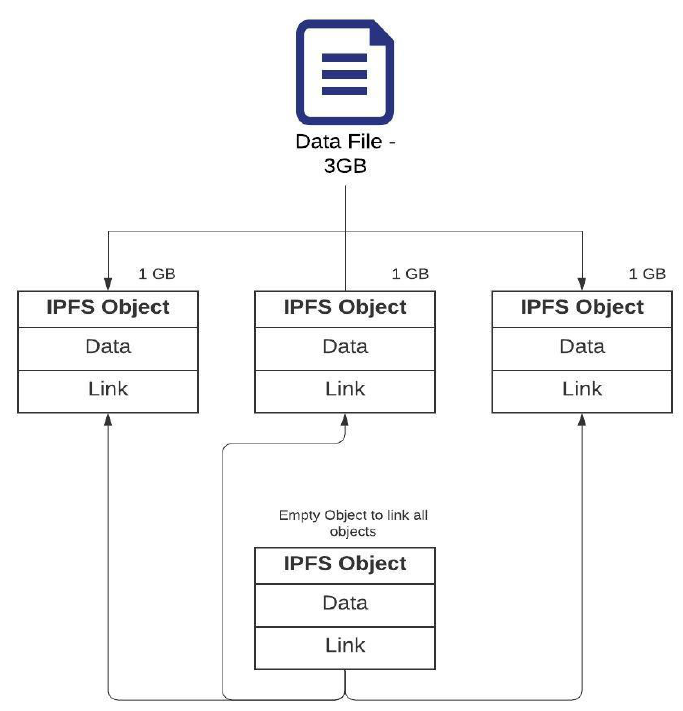
Figure 4. Data sharing with an IPFS (example).